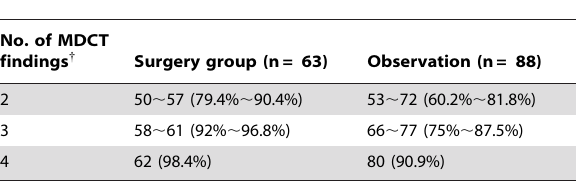
Table 4. Number of patients who would be identified by using combinations of MDCT findings to predict adhesion- related SBO patients requiring